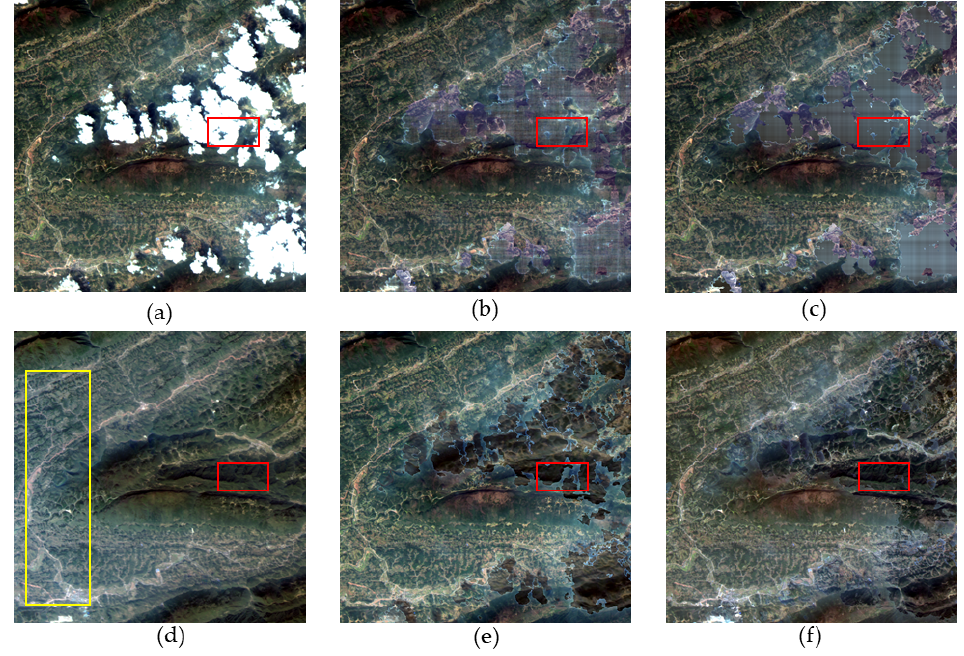
Figure 16. Gaofen-1 WFV images for the second real-data experiment: ( a ) cloud image; ( b )–( f ) the results of FaLRTC, HaLRTC, TRPCA, TVLRSDC, and TSSTO, respectively.